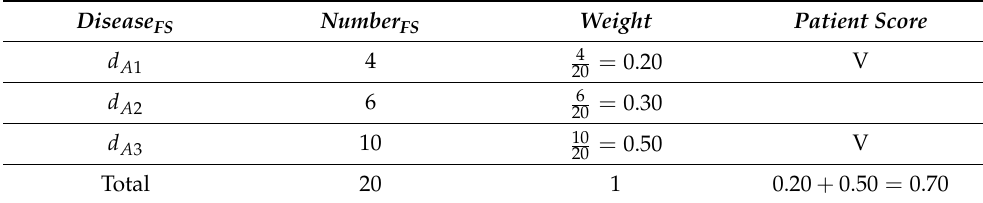
Table 2. Simple illustration of scoring mechanism. Disease